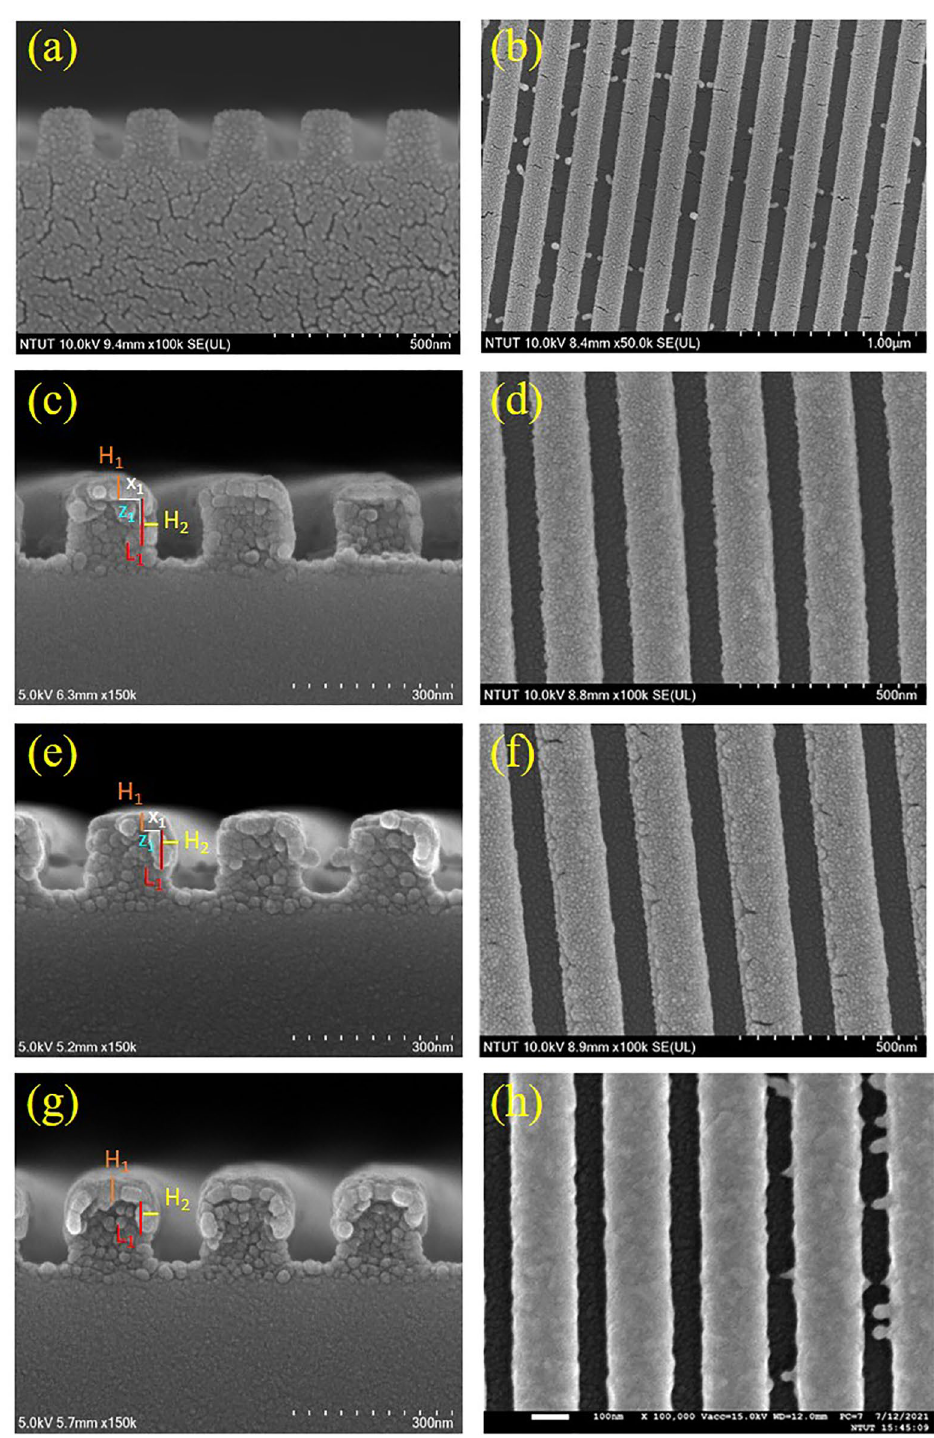
Figure 1. Scanning electron microscopy (SEM) images of fabricated SNTAs. ( a ) Cross-sectional and ( b ) top- view images of bare grating. ( c ) Cross-sectional and ( d ) top-view images of SNTA-1. ( e ) Cross-sectional and ( f ) top-view images of SNTA-2. ( g ) Cross-sectional and ( h ) top-view images of